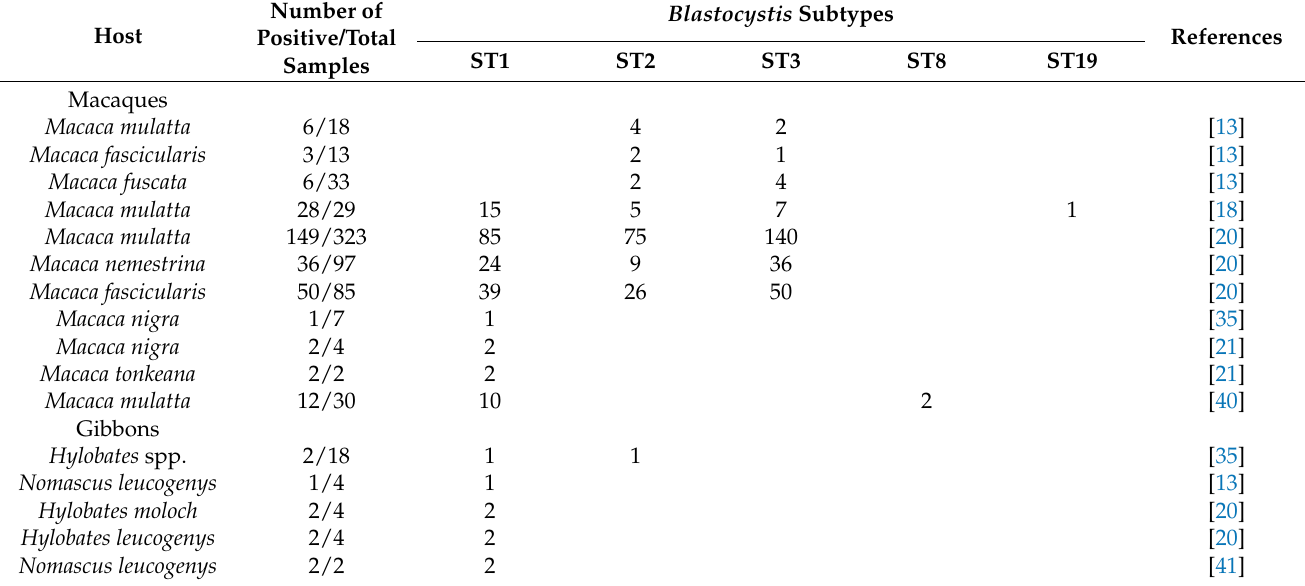
Table 1. The prevalence and subtypes of Blastocystis reported in macaques and